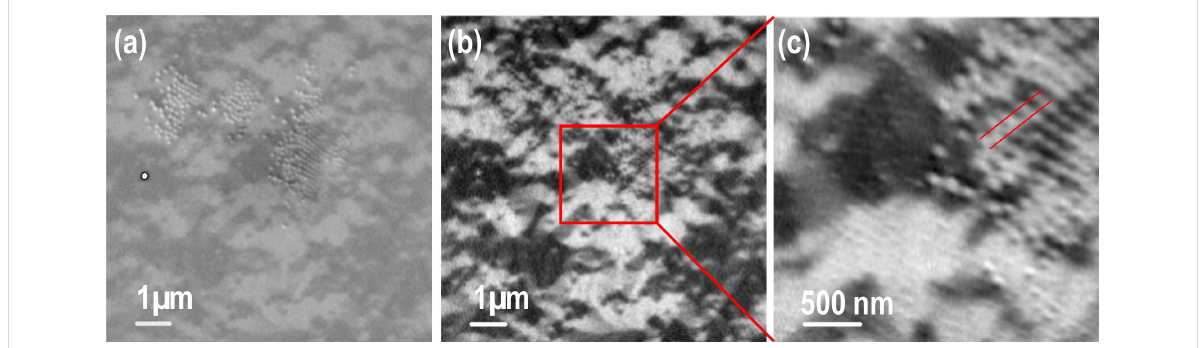
Figure 6: (a) Scanning transmission X-ray microscopy images of Fe films taken with right circularly polarized light at the Fe-L 3 edge show PS parti- cles as well as magnetic contrast in the film after sample demagnetization. Panel (b) presents the XMCD image of the identical sample spot. In (c) an XMCD image at higher resolution is shown revealing two regions (lower left and top right) of different PS particle diameters. The underlying domain sizes appear strongly varied in these regions.